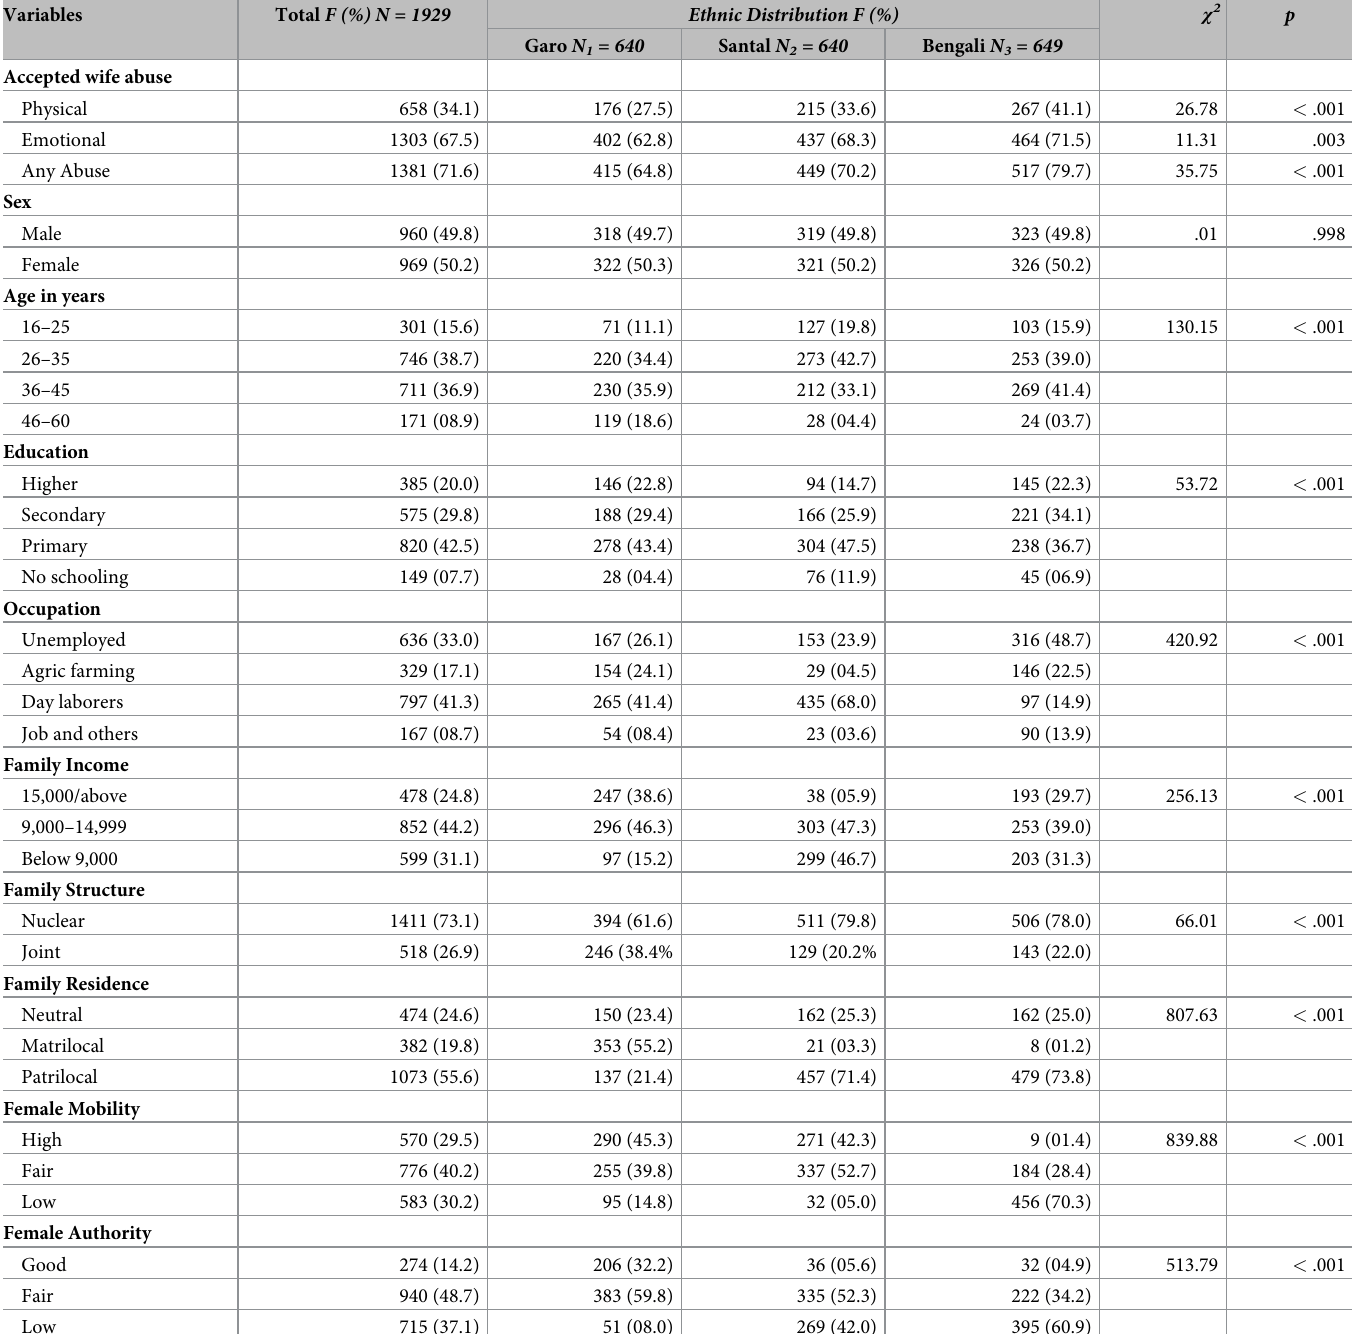
Table 2. Demographic profile and bivariate ethnic differences in the variables, N =